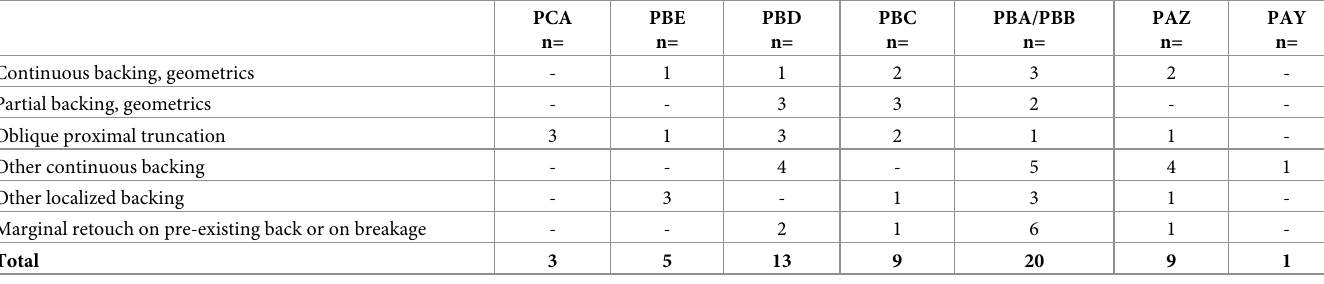
Table 6. Categories of backed tools identified at